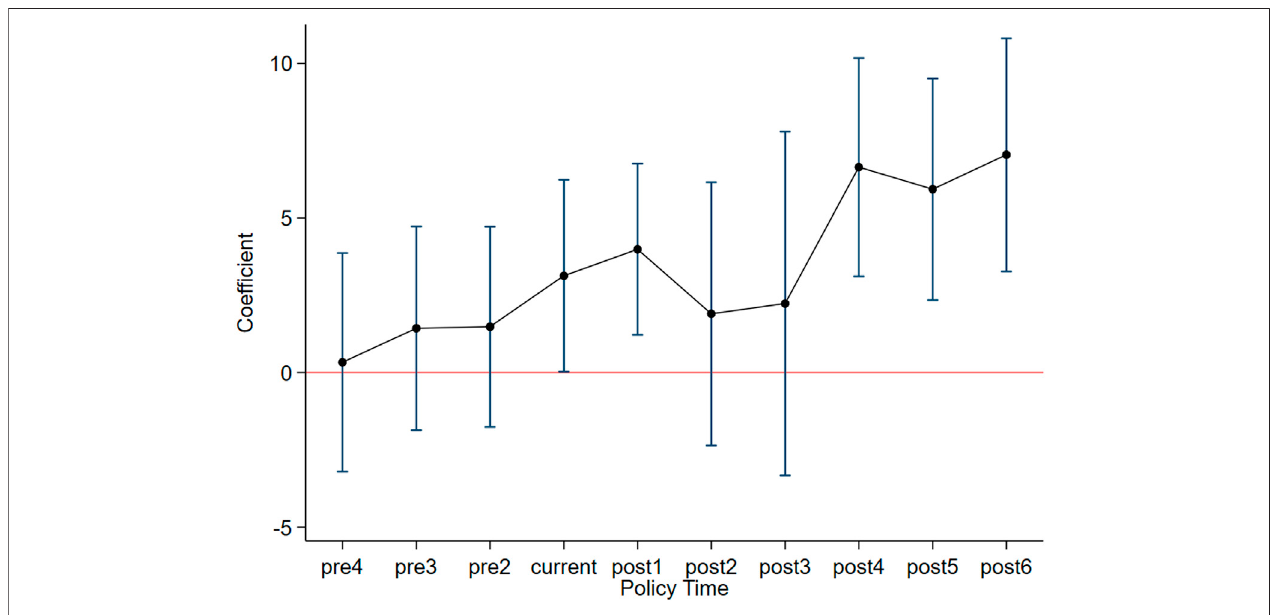
FIGURE 6 | Parallel trend